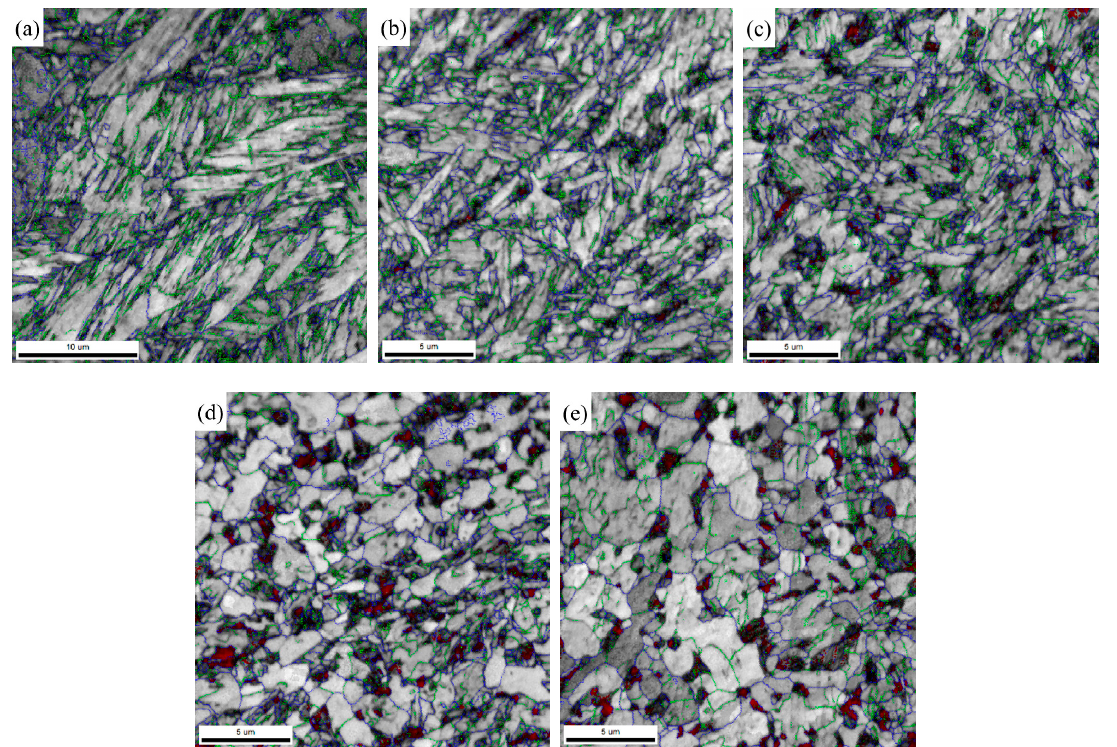
Figure 7. Image quality combined with grain boundaries: ( a ) FZ; ( b ) HAZ, point b; ( c ) HAZ, point c; ( d ) HAZ, point d; ( e ) BM (the red phase represents retained austenite, green line represents boundary 2° < θ < 15°, and blue line represents θ > 15°).